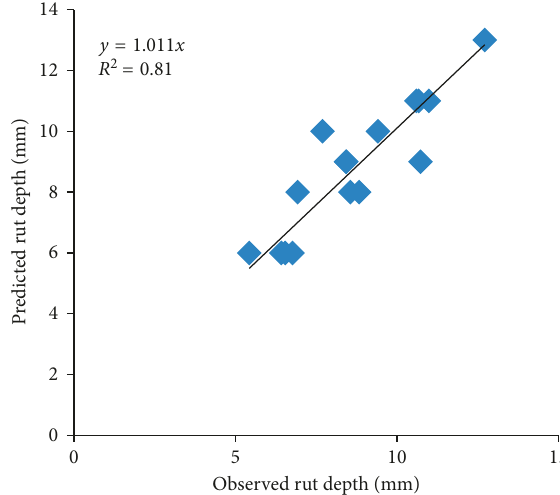
Figure 24: Scatter plot between observed versus predicted potholes for validation (2015).